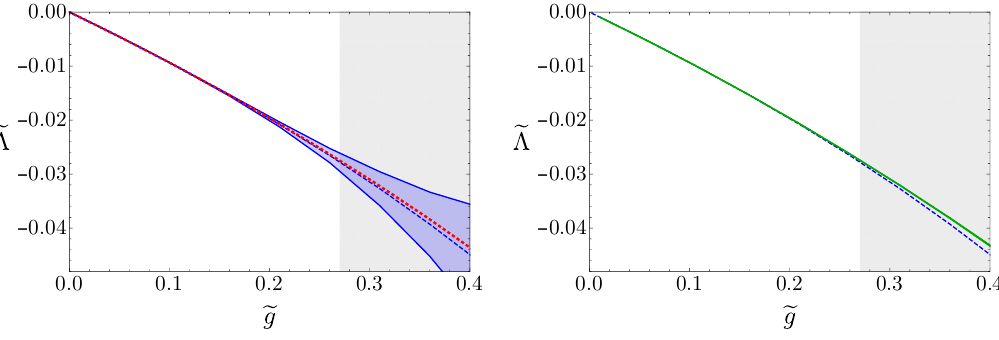
Figure 5 . The vacuum energy (cid:3) as a function of the coupling constant g using the coe(cid:14)cients up to the g 4 order. Left panel: the results obtained using the conformal mapping (5.2) (light blue) e with parameters s = 1 = 5, b = 0 and the optimally truncated series (red dotted line) which coincides e with the perturbative series up to g 4 for the couplings shown in the plot. Right panel: comparison e between the central values of the conformal mapping (blue dashed line) and Pad(cid:19)e-Borel (solid green) resummation techniques. The regions beyond the phase transition g > g ( w ) c are shaded in e e e